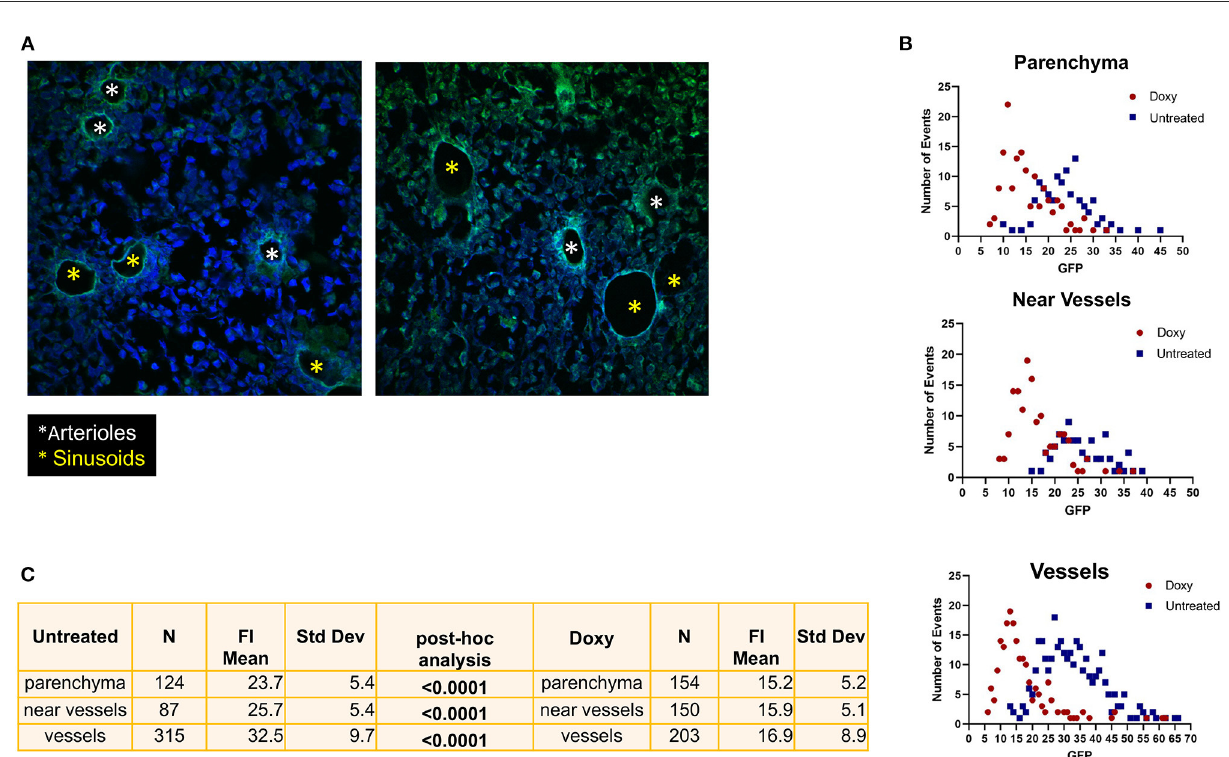
FIGURE7 Treatment with Doxy specifically reduces the GFP levels expressed by cells surrounding venules. (A) Confocal microscopy analyses of the femur from representative untreated and Doxy-treated mice stained with DAPI and GFP. The images indicate that in untreated mice cells expressing high levels of GFP surround both arterioles (white asterisks) and venules (yellow asterisks) while in the Doxy-treated animal high GFP expression is retained only by cells surrounding the arterioles. (B) Distribution of the GFP fluorescence intensity expressed by single cells from the BM of untreated (blue dots) or Doxy-treated (red dots) mice (two mice per group) according to their localization within the BM architecture (each symbol a different cell). (C) Number of single cells analyzed and Mean ( + / − SD) of the levels of GFP expressed by the single cells from the BM of untreated or Doxy-treated mice according to their localization. The p -values were calculated by ANOVA with a post-hoc